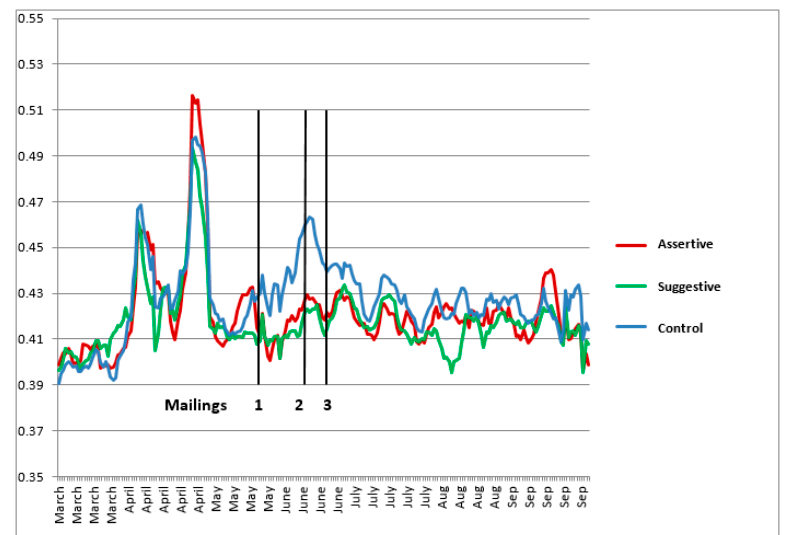
Figure 1. Average household consumption by type of treatment—seven-day running average (cubic meters per day).